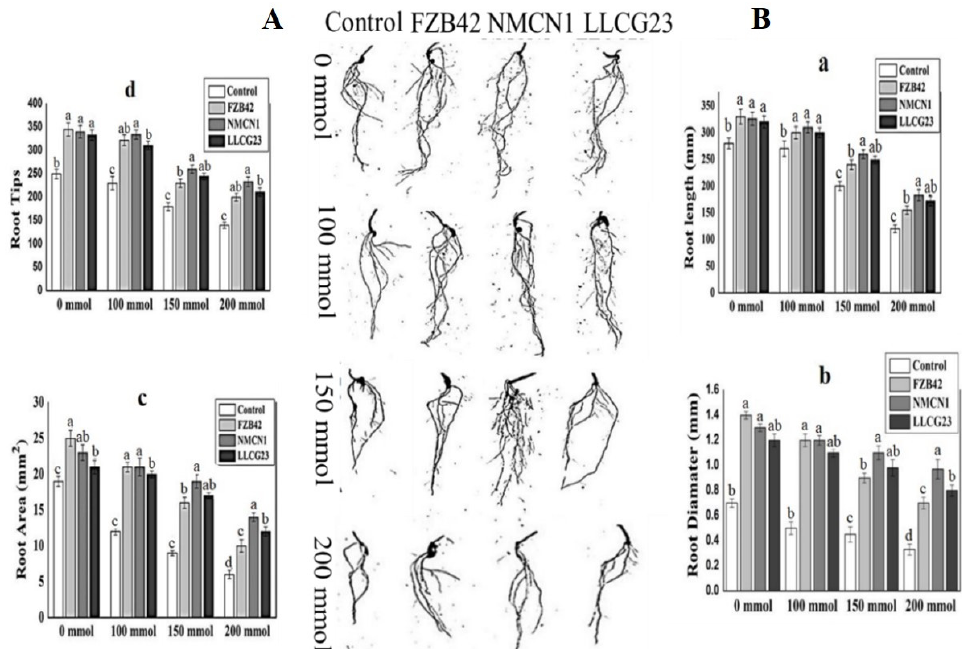
Figure 8. Wheat roots rhizoscanning image under different saline conditions (0 mmol–200 mmol)